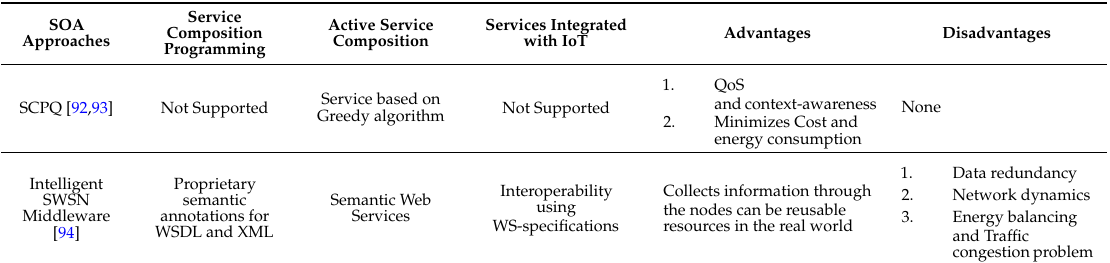
Table 8. Analysis of Service Composition Architectures for